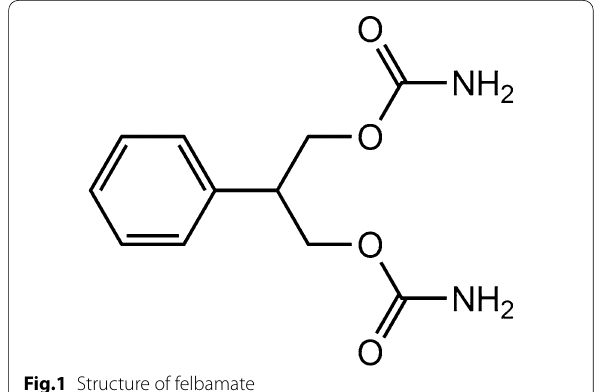
Fig.1 Structure of